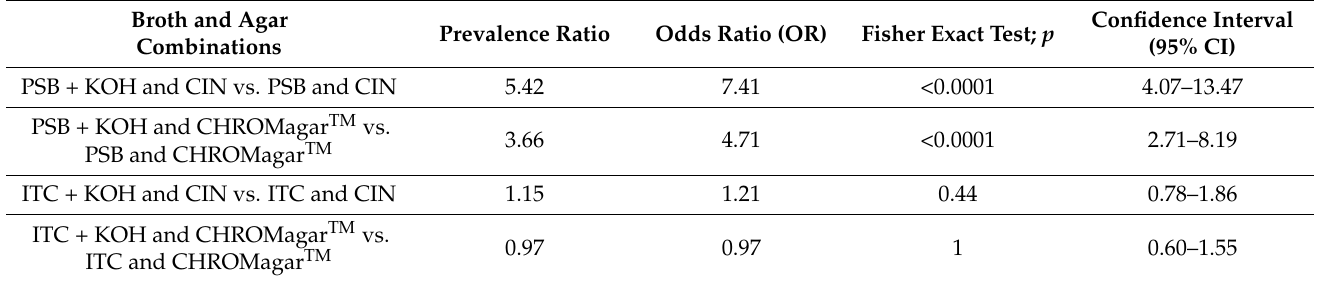
Table 4. Y. enterocolitica odds ratio and prevalence ratio between alkali-treated and untreated